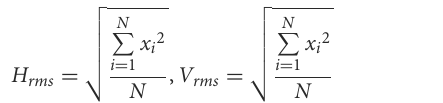
more effectively when detecting SSVEP (Chen et al., 2015a). The FBCCA method consists of three main steps. Firstly, the input EEG data is decomposed into N sub-band components by a band-pass filter set. Then the CCA method is performed on each of the N